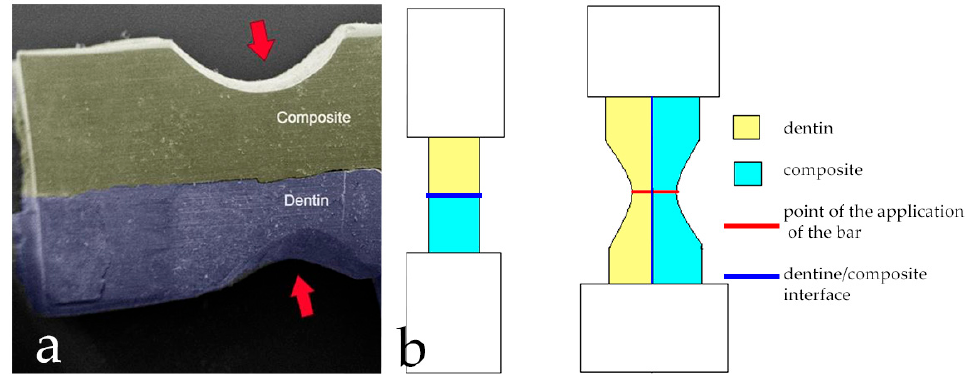
Figure 2. Notches creation: ( a ) The red arrows indicate the pre-crack areas; ( b ) Comparison between Conventional Test and bi-material Curved Test. In Curved Test, notches (created both on the dentine and composite sides) will be the pre-cracks from which the two fracture lines originate.